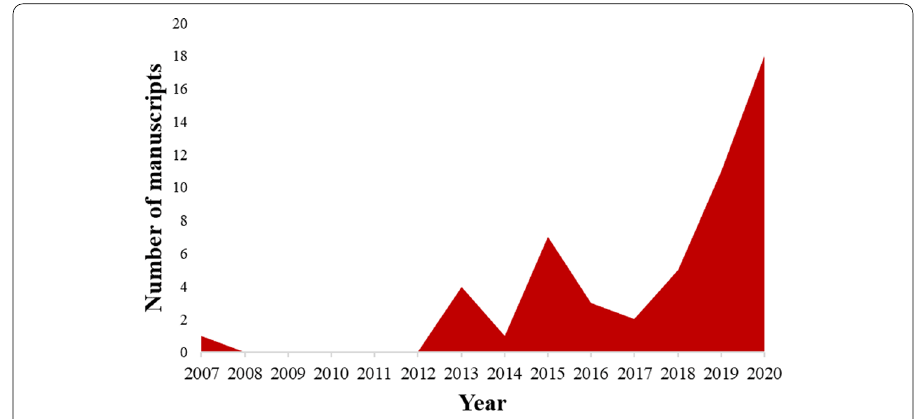
Fig. 2 Evolution of research on TDC from 2000 to